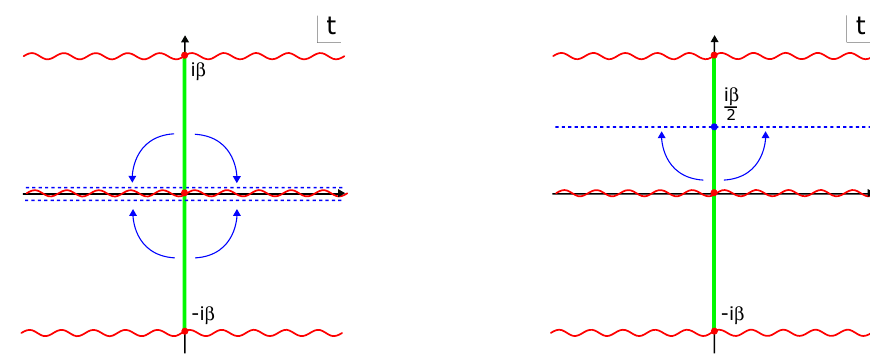
Figure 7 . Left: analytic structure of the two-point function. The green line represents the Eu- clidean regime. Time-ordered and anti-time-ordered Lorentzian two-point functions can be found by analytically continuing these expressions to respectively t analytic continuation for the thermo(cid:12)eld double two-point